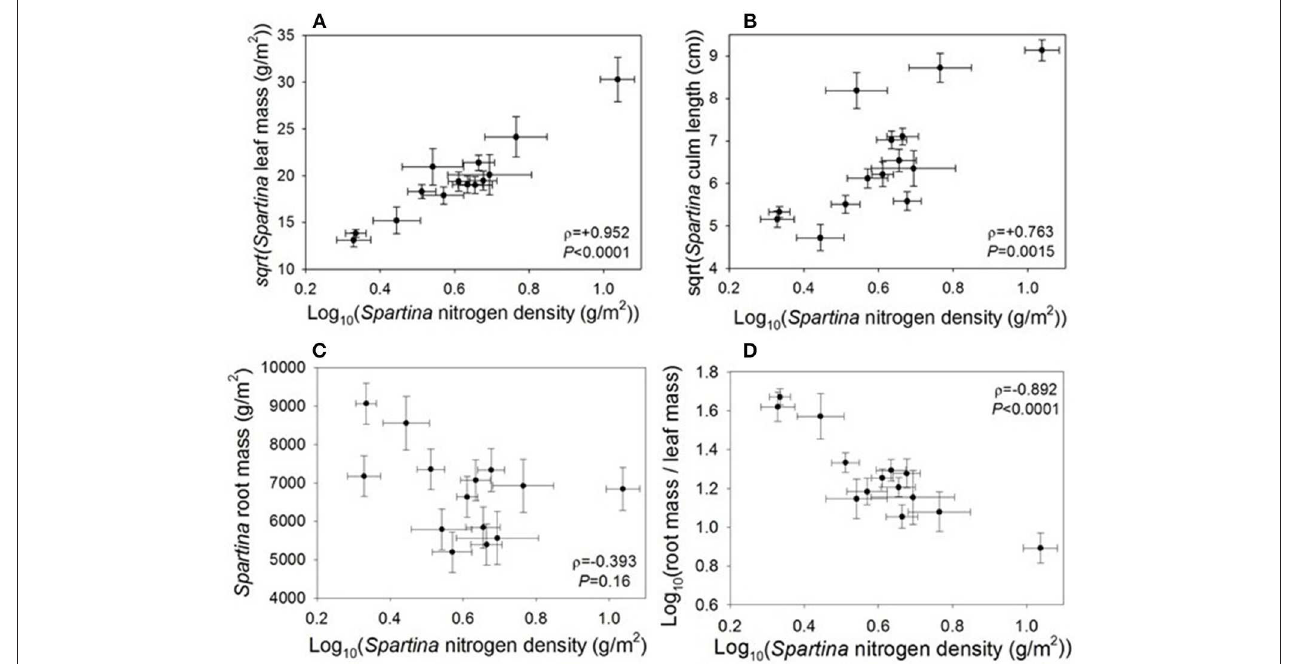
FIGURE 2 | Correlations between Spartina nitrogen density and Spartina (A) leaf biomass, (B) culm length, (C) root biomass when we remove the site with the highest nitrogen density the root biomass result becomes significant ( ρ = − 0.583, P = 0.037), and (D) root-to-shoot ratio.